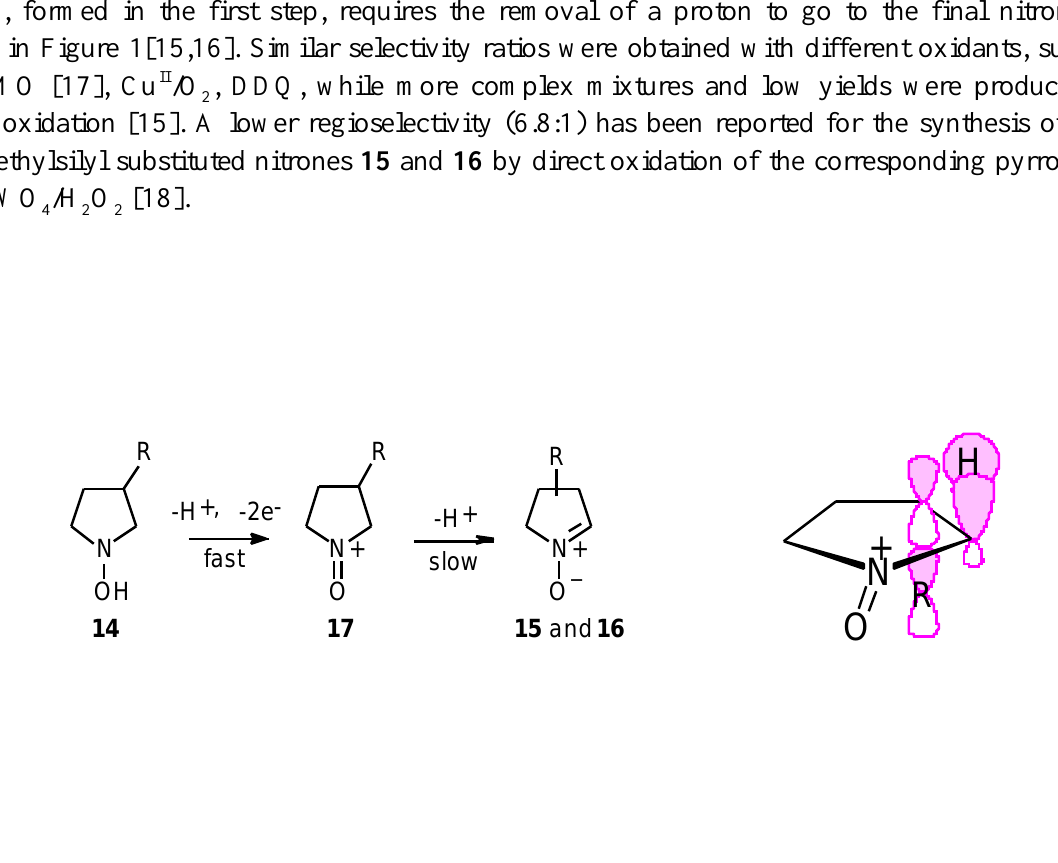
Figure 1. Mechanism proposed for the oxidation of N -hydroxypyrrolidines and representation of the orbital interaction which justifies the observed